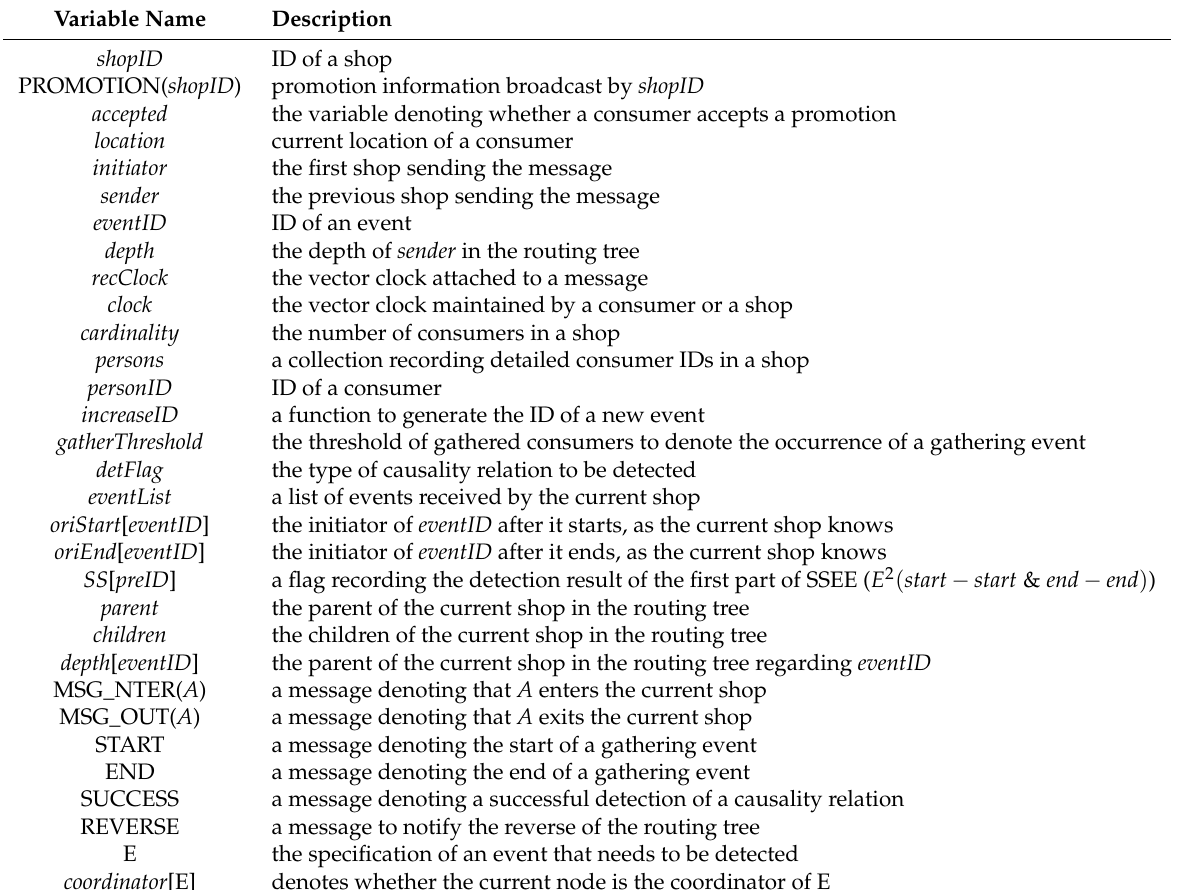
Table 1. Notations in the